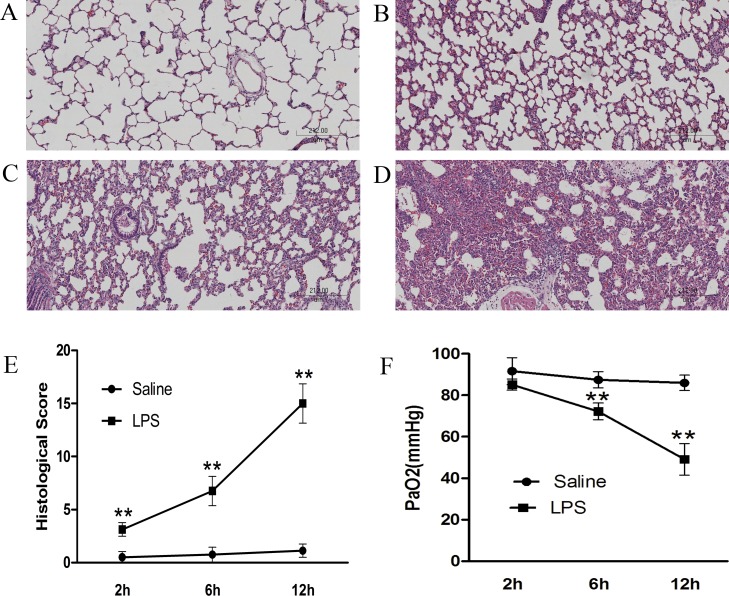
Changes in lung histopathology and PaO2 after intratracheal instillation of LPS or saline in rats.After 2, 6 or 12 h interventions, the right upper lobe of the lung was fixed and tissue sections were stained with H&E. Representative histological changes in lung tissues obtained from (A) the saline group and LPS groups (B: LPS 2 h, C: LPS 6 h, D: LPS 12 h). (E) Semi-quantification of histological changes and (F) PaO2 changes demonstrated that lung injury worsened with increased time. The results are presented as mean±SD (n = 8 each group). **p<0.01 compared with control rats at the same time point. LPS: lipopolysaccharide; H&E: hematoxylin and eosin; SD: standard deviation.